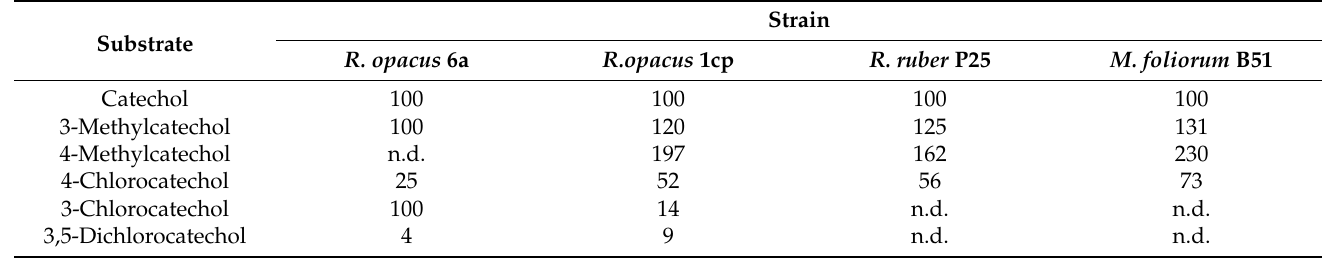
Table 3. Substrate specificity (in %) of (C) Cat 1,2-DO in cell-free extracts of strains grown with